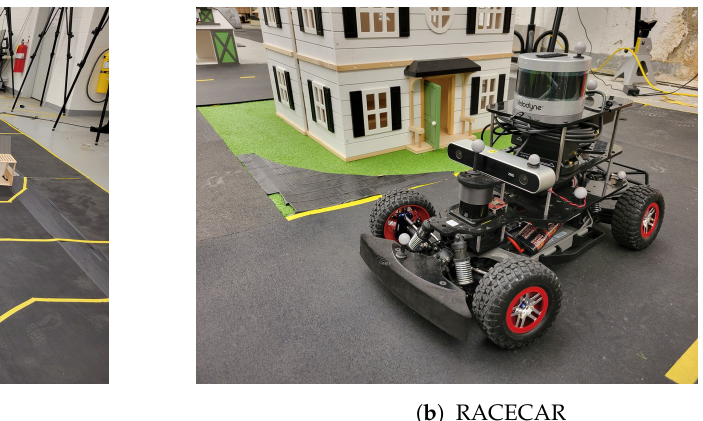
Figure 1. The MiniCity. ( a ) MiniCity consists of multiple intersections and vehicles for testing. ( b ) Miniature RACECARs equipped with sensors driving around scaled houses and